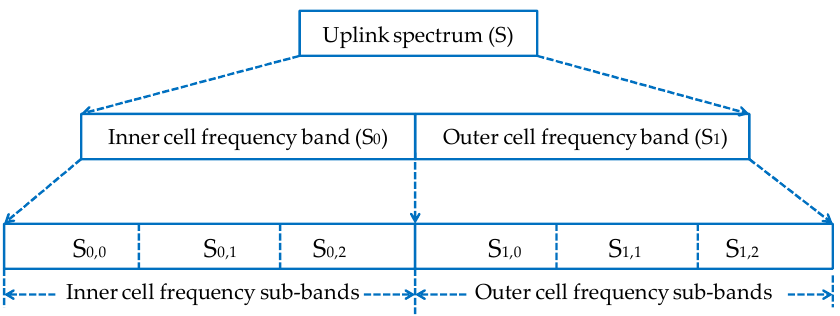
Figure 2. Uplink frequency partitioning using the FFR scheme.